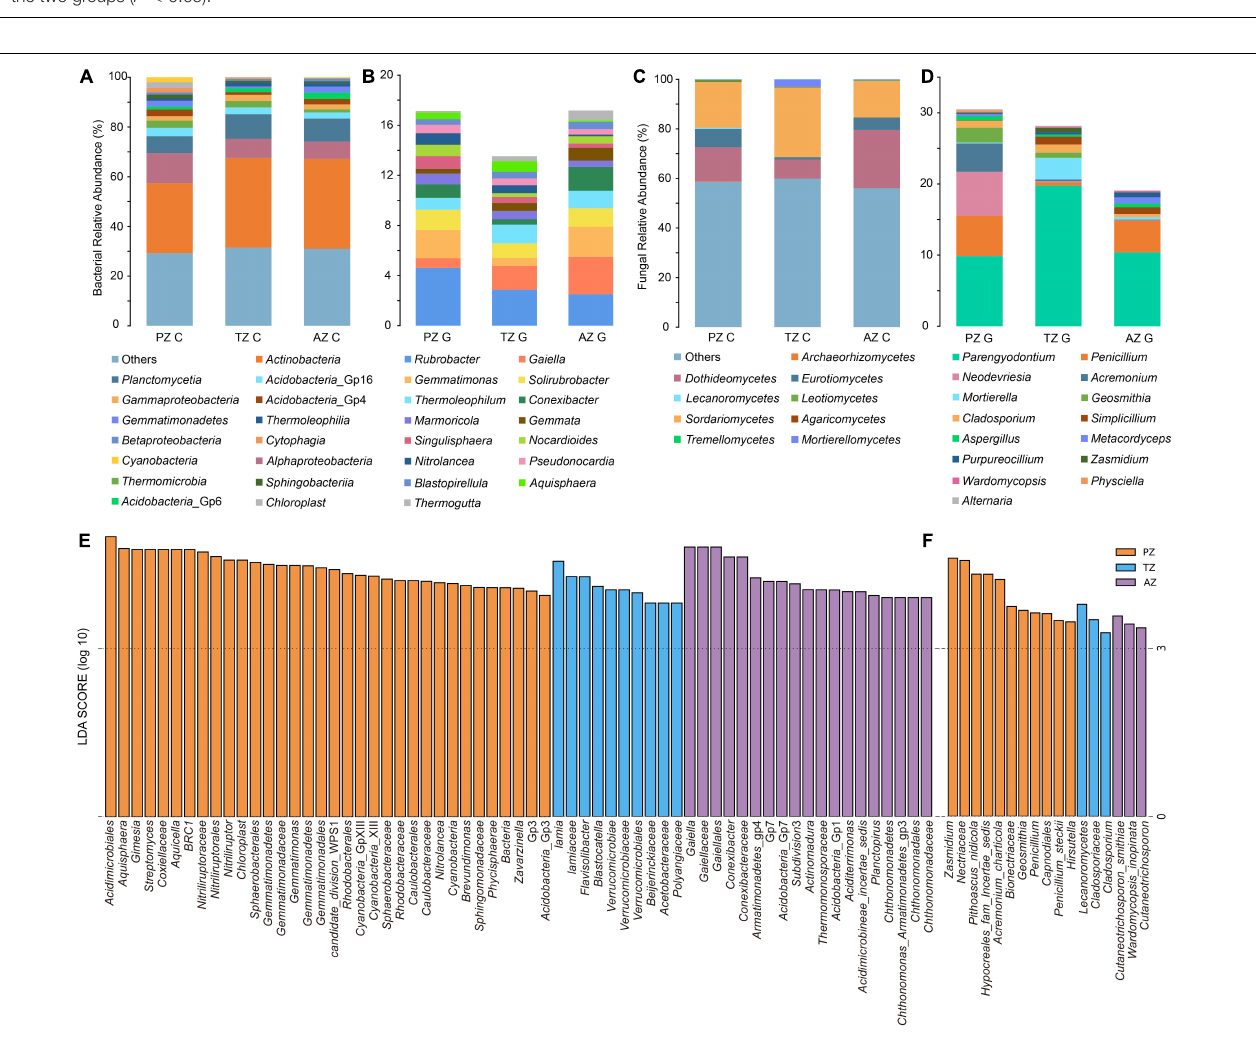
FIGURE 2 | Bacterial (A,B) and fungal community (C,D) compositions of the top 15 classes (A,C) and genera (B,D) of weathered rocks in the Heshang Cave. Linear discriminant analysis (LDA) effect size taxonomic histogram with LDA = 4 of bacterial (E) and LDA = 3 of fungal (F) communities of the weathered rocks in the Heshang Cave, Hubei province, China. PZ: photic zone, TZ: twilight zone, AZ: aphotic zone. C and G after the sampling zone abbreviation indicate classes and genera of microbial taxonomy in the corresponding sampling location.